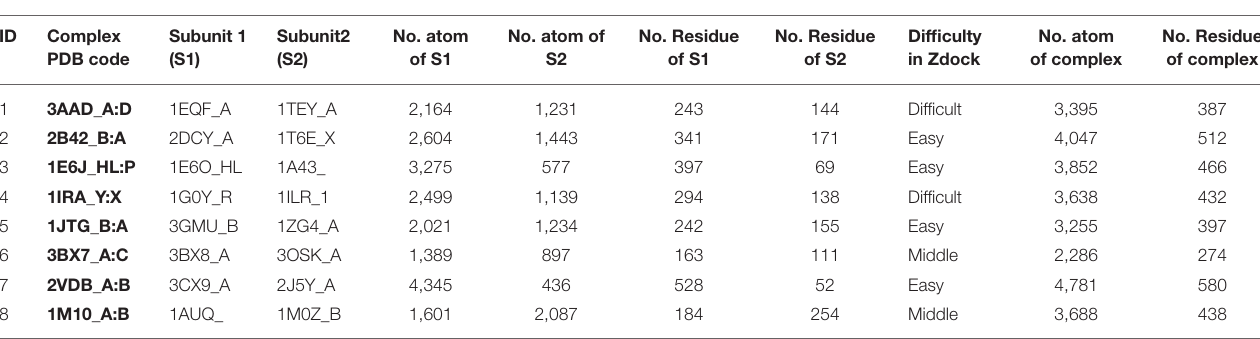
TABLE 1 | The characteristics of the molecular complexes.